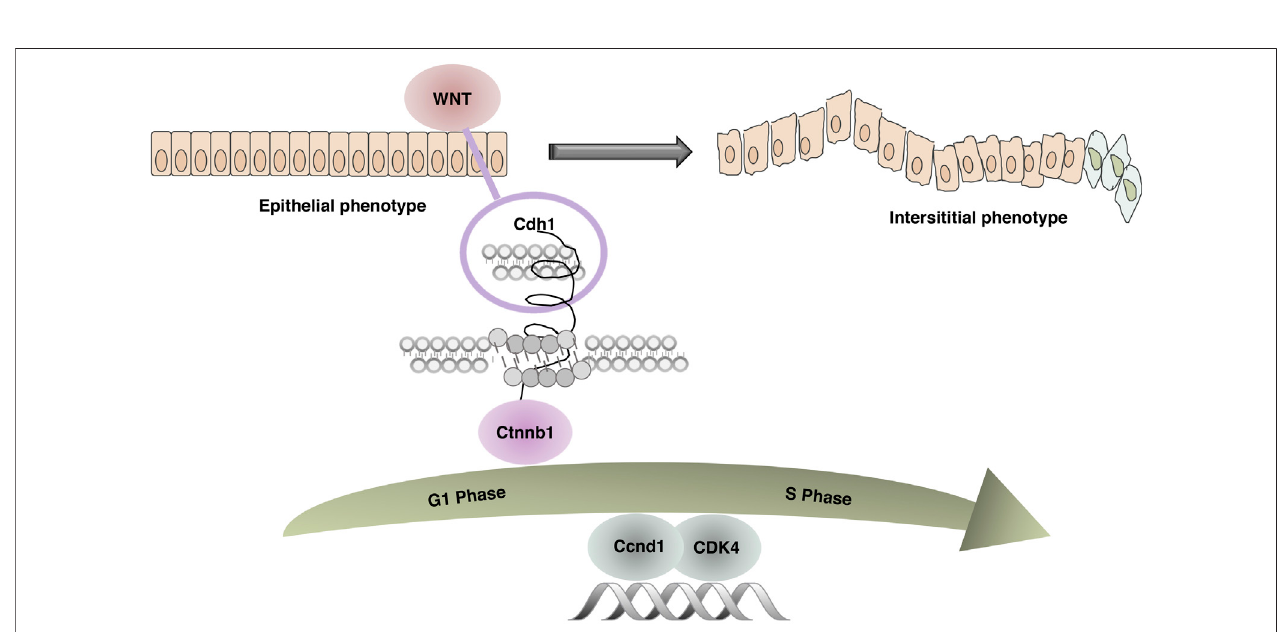
FIGURE 12 | Related mechanism diagram. In the combined AOM/DSS-induced CAC mouse model, due to continuous in fl ammatory stimulation and repeated tissue damage, the WNT pathway was activated. Cdh1 and Ctnnb1 no longer interacted leading to unstable intercellular adhesion junctions, abnormal epithelial proliferation, accelerated tissue repair, dysregulation of cell cycle G1/S restriction point control, and abnormal expression of key regulators Ccnd1 and CDK4.